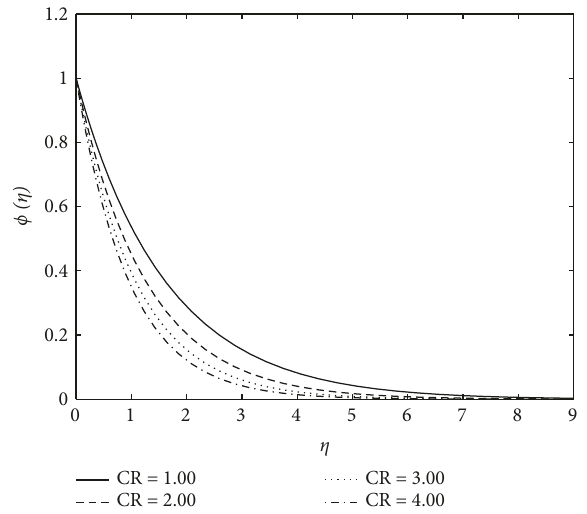
Figure 17: Change in the value of ∅ ( η ) for different values of CR. Table 3: The local skin friction coefficient, the Nusselt number, and the local Sherwood number coefficient for different values of K , Γ , C and Pr , when λ � 0 . 1 , Rd � 0 . 2 ,Ec � 1 , M � 0 . 1 , Sc � 0 . 22 , c � 0 .